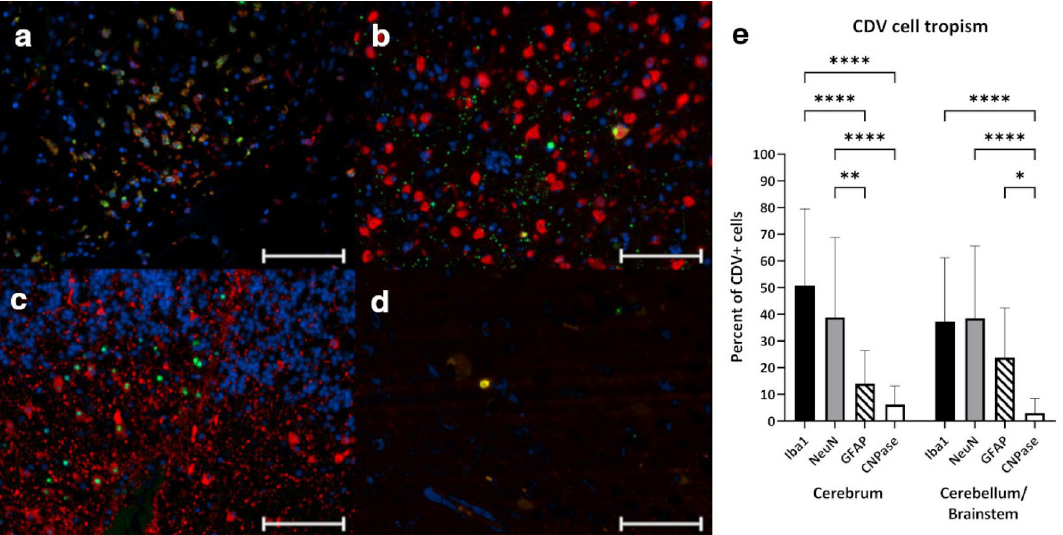
Figure 3. Cellular tropism of canine distemper virus in foxes. Detection of CDV N antigen (green) in ( a ) microglia/macrophages (Iba1, red), cerebrum. ( b ) neurons (NeuN, red), cerebrum. ( c ) astrocytes (GFAP, red), cerebellum. ( d ) oligodendrocyte (CNPase, red), cerebrum. (e) Percentage of infected cells displaying cell specific markers. Bars display mean values and standard deviations. Asterisks indicate statistical significance levels,